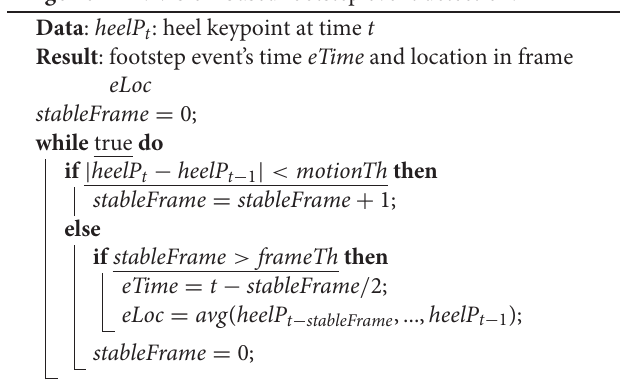
Algorithm 1: Vision-based footstep event